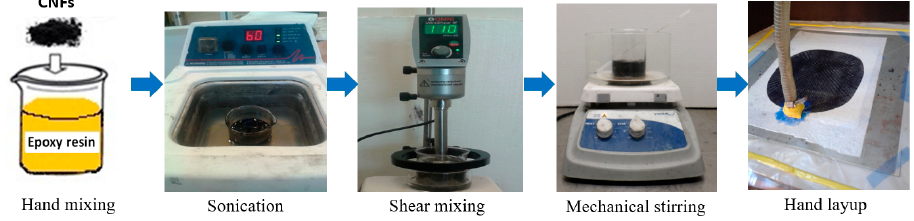
Figure 1. Schematic representation of glass fiber composite fabrication incorporating CNFs.